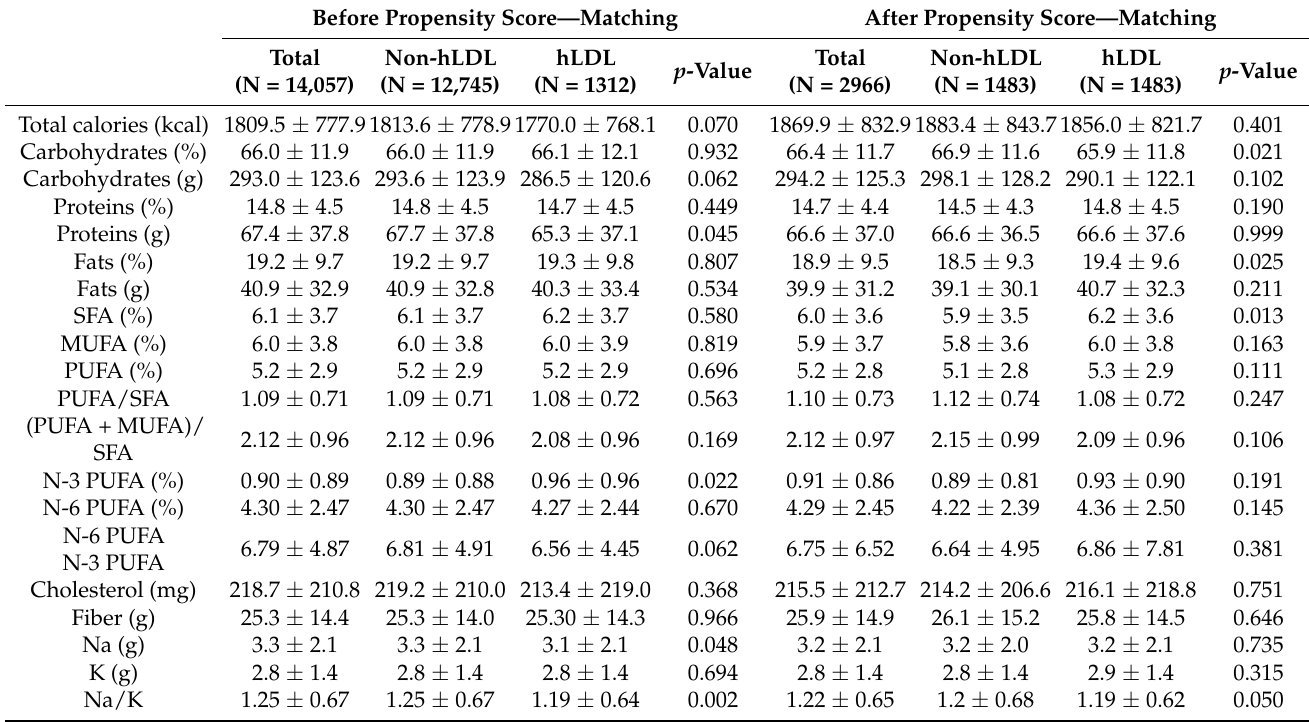
Table 2. Daily nutrient intake of study population according to the presence of hyper-low-density lipoprotein cholesterolemia. Before Propensity Score—Matching After Propensity